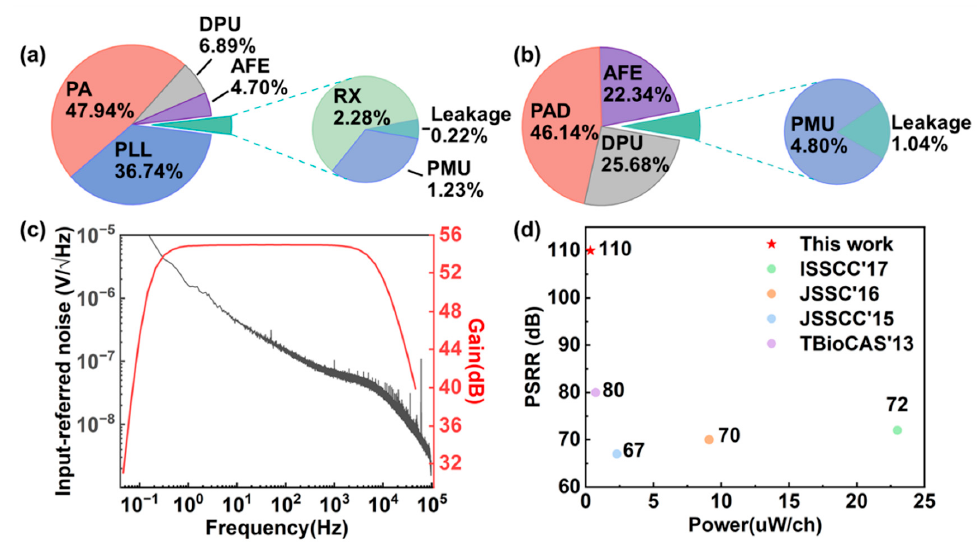
Figure 5. Measured performance of the custom-designed chip. ( a ) Power distribution in wireless mode with a total power of 2.28 mW. ( b ) Power distribution in wireline mode with a total power of 0.48 mW. ( c ) The measured transfer characteristic and input-referred noise of a typical AFE channel. ( d ) Comparison of the PSRR and power consumption of the signal-channel AFE.